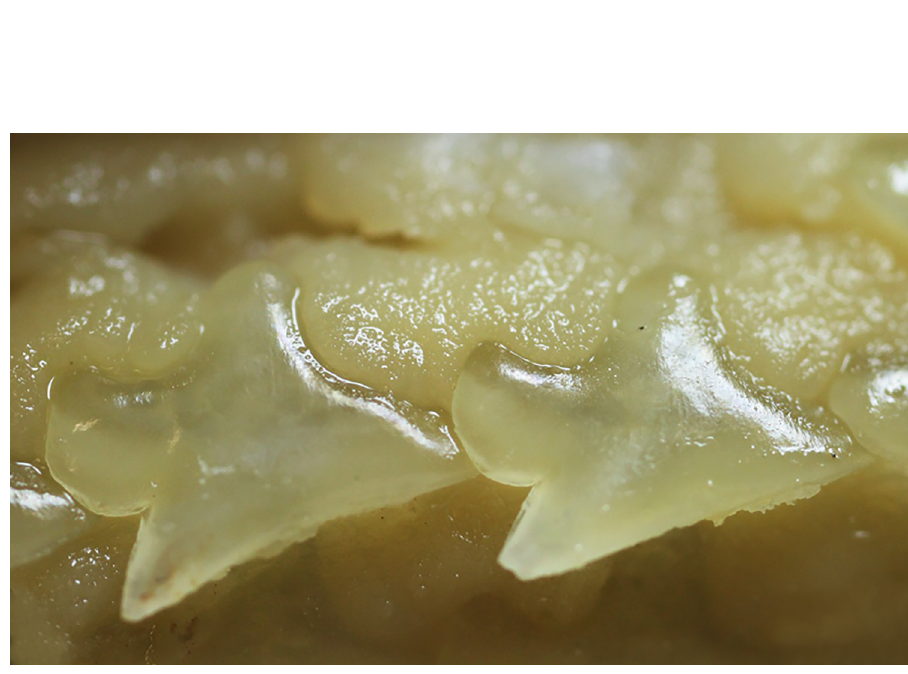
Fig 22. Upper teeth (labial view) of the paratype of C . asper , BMNH 1972.10.10.2, adult male, 847 mm